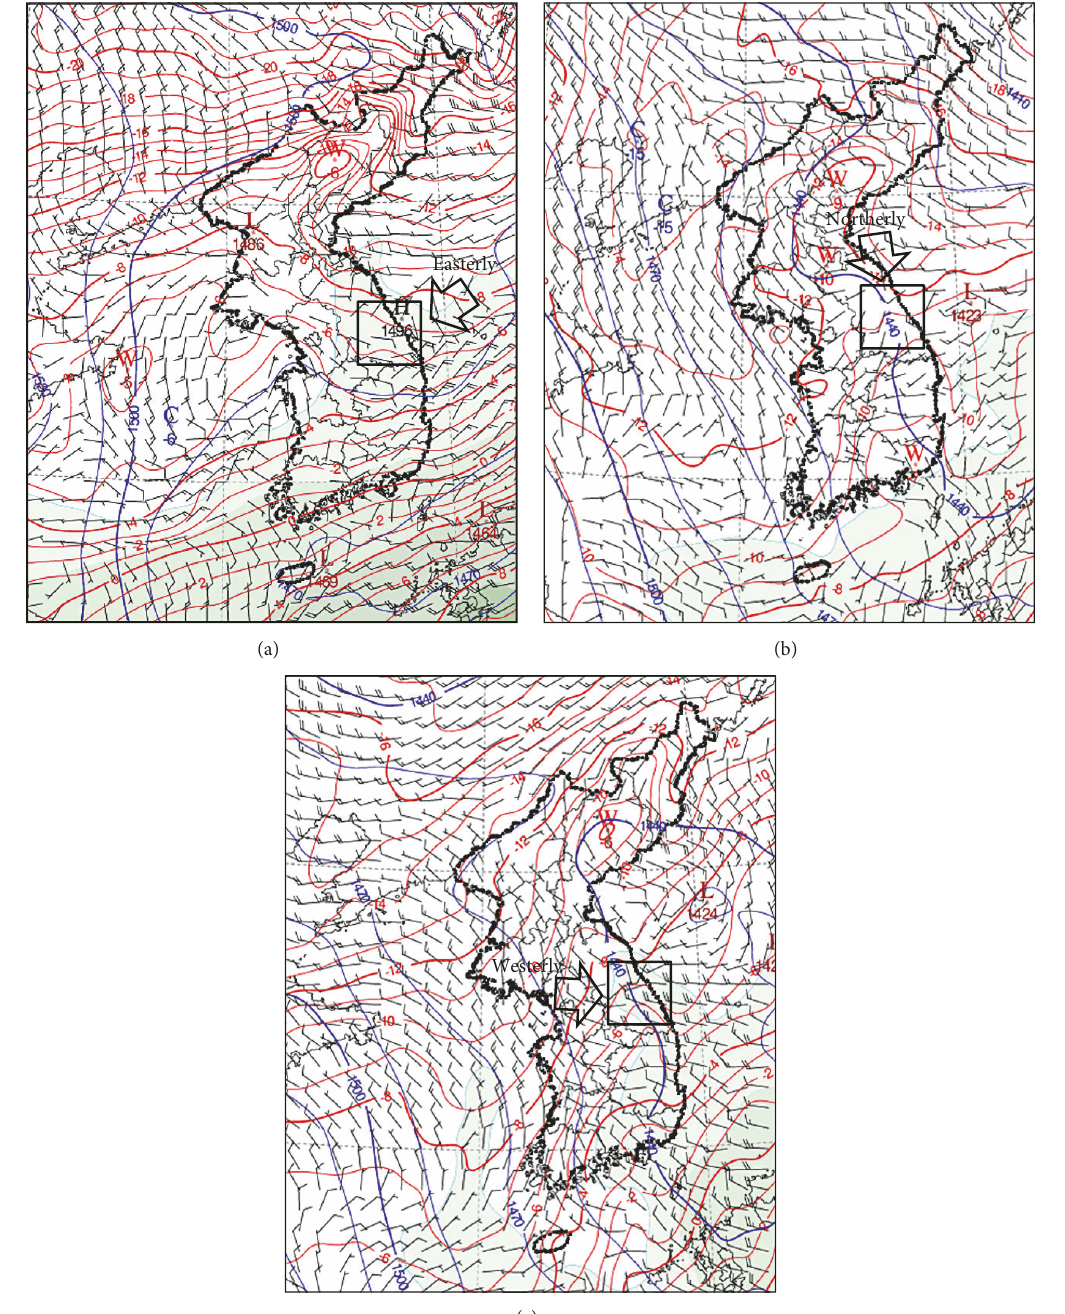
Figure 2: 850 hPa synoptic charts at 1500 LST of (a) EXP1, (b) EXP2, and (c) EXP3 from the Korea Local Analysis and Prediction System (KLAPS). The box denotes the simulated domain, and the arrow is the wind direction at the seeding